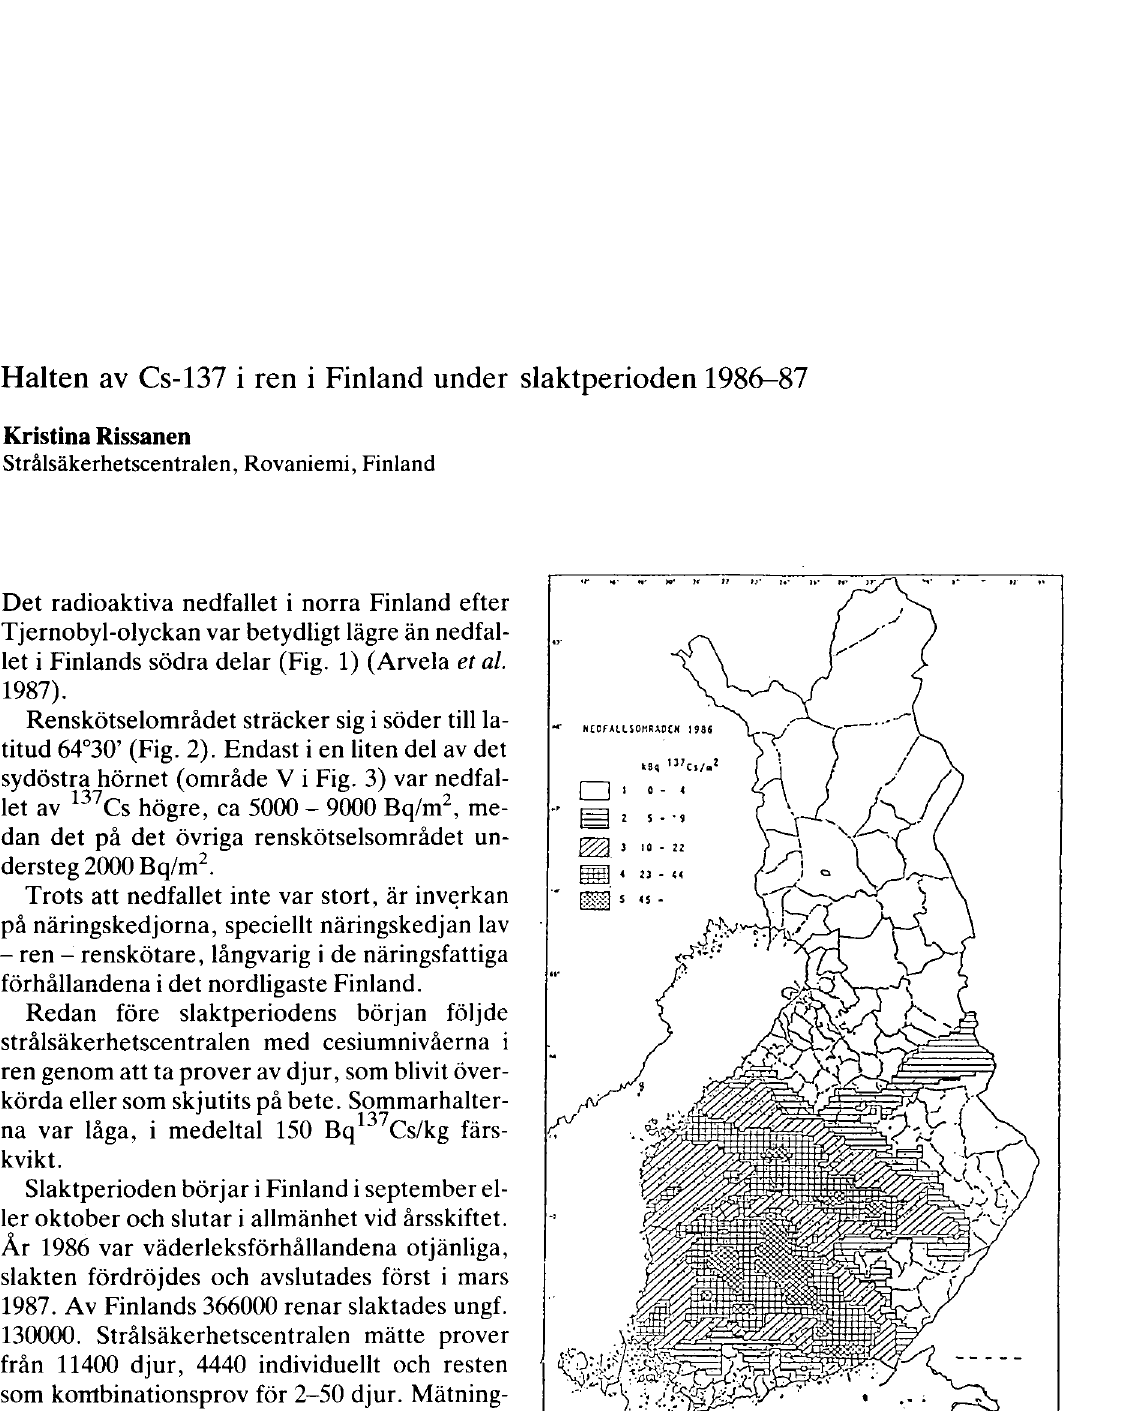
Figur 1. Karta over Cs-nedfallets variation